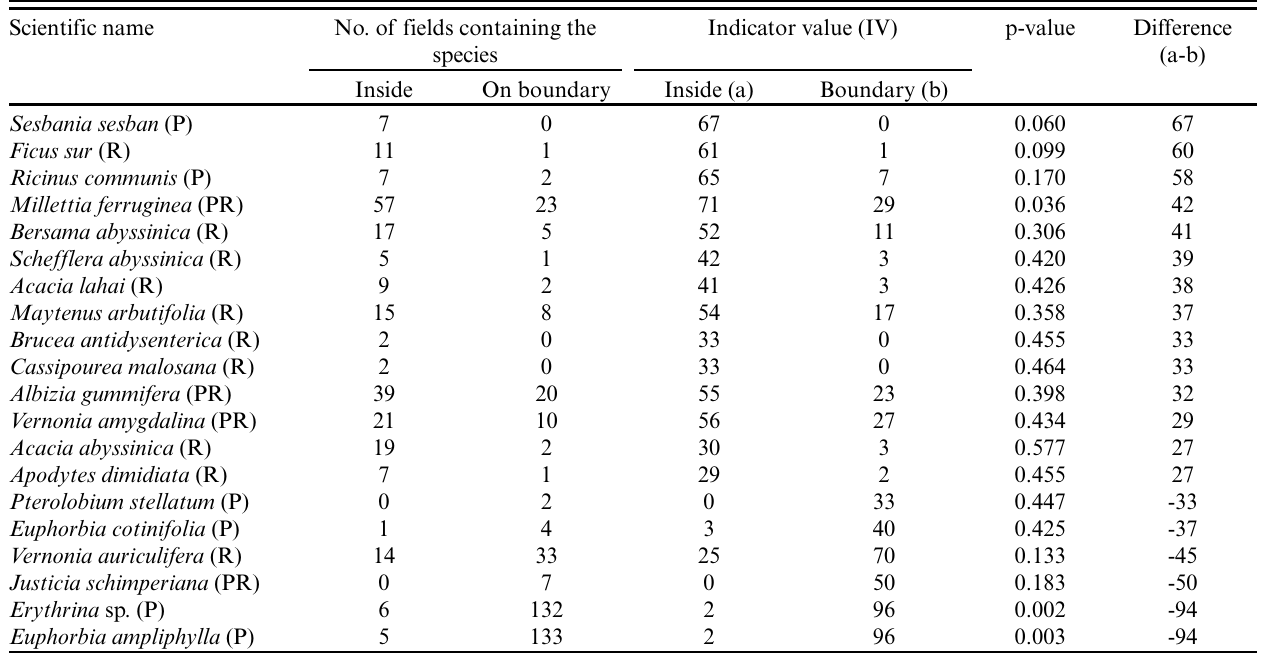
Table 3 . Indicator species values for tree species with an indicator value difference of more than 25 between inside and field boundaries. The table is sorted according to the difference, implying that species that are more often found inside fields have a positive value and species found at the boundaries have a negative value. P: Planted trees. R: Retained trees (from previous natural forest, coppice, or regrowth). PR: Planted or retained.